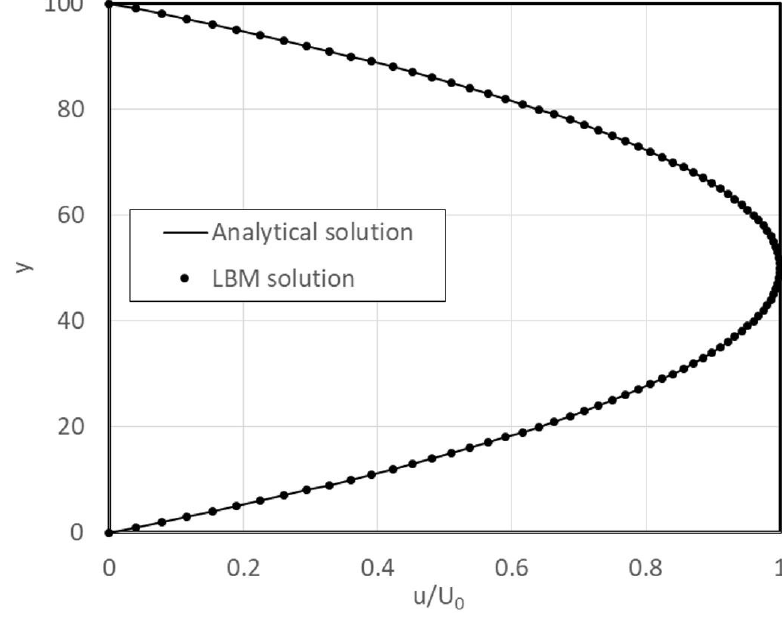
Figure 13. Comparison of velocity profiles for the LBM and analytical solution in the Poiseuille